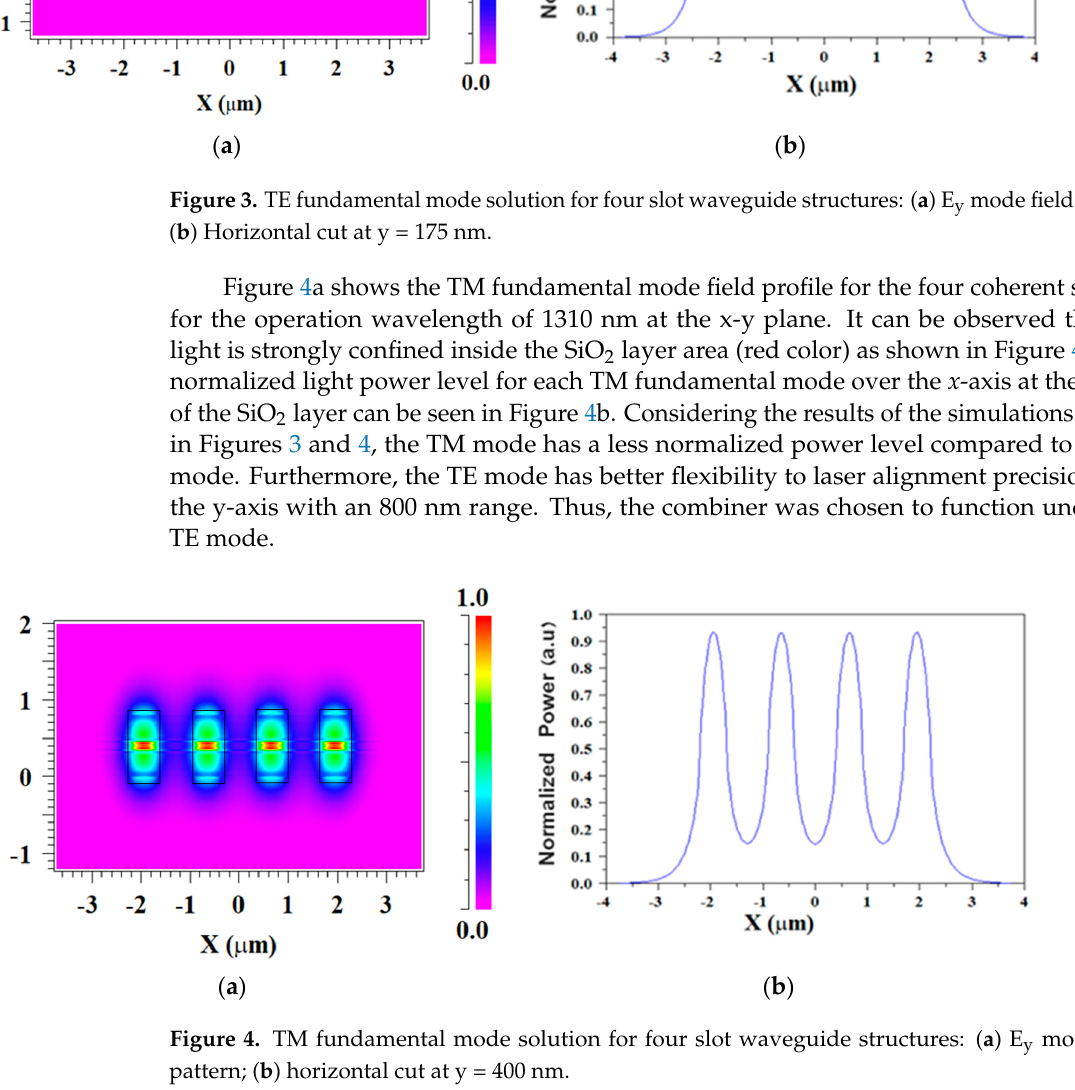
( b ) Figure 5. Optimizations of the MMI coupler geometrical parameters: ( a ) normalized power vs. W MMI; ( b ) normalized power vs. L MMI . The input waveguide taper locations were optimized to avoid light coupling between closer laser sources and using FV-BPM simulations. The optimal Gap was found and its value is 0.75 μ m. The length of the input taper is 17 μ m with a width that varies between